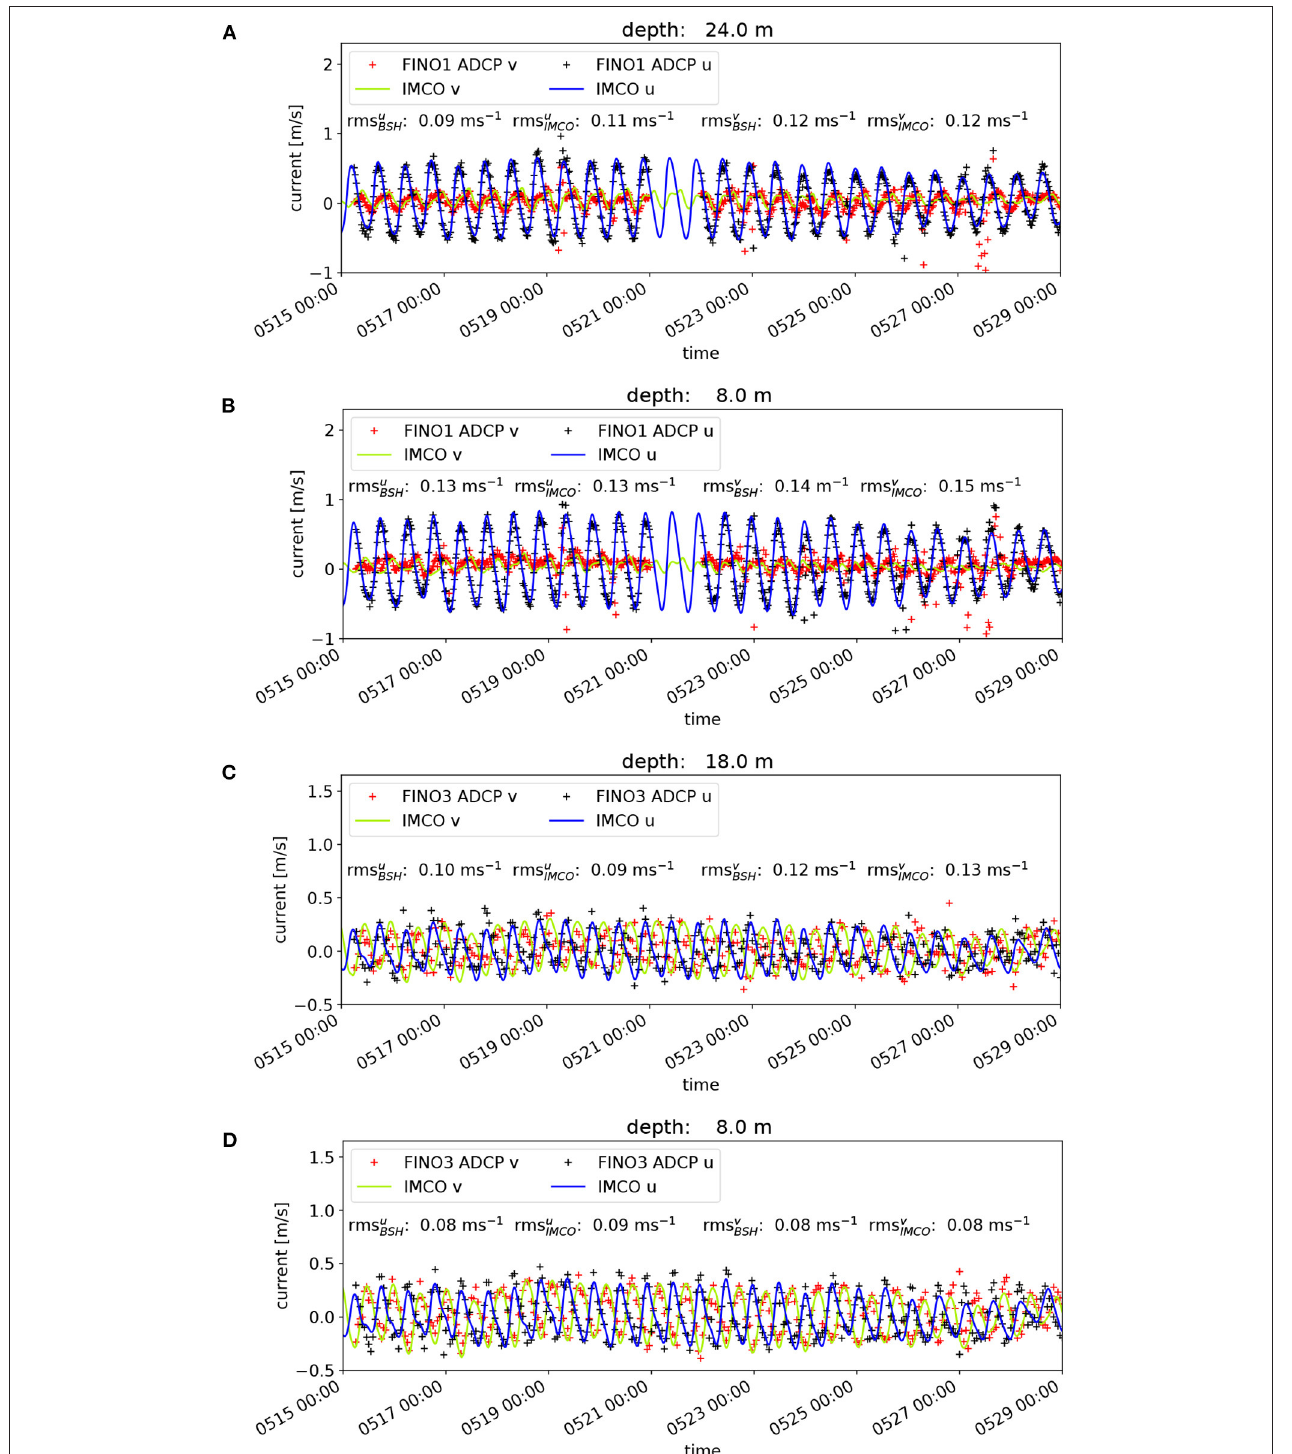
FIGURE 5 | Comparison of FINO-1 (A,B) and FINO-3 (C,D) ADCP current measurements at two depths with 4DVAR analysis results for the period May 15–May 29, 2015. Measurements at 8 and 24 m are shown for FINO-1 whereas FINO-3 observation were taken at 8 and 18 m. Black and red crosses indicate zonal and meridional components of the measurements while the blue and green curved correspond to the zonal and meridional components of the 4DVAR analysis. RMS values are given for the comparisons with BSH model data as well.